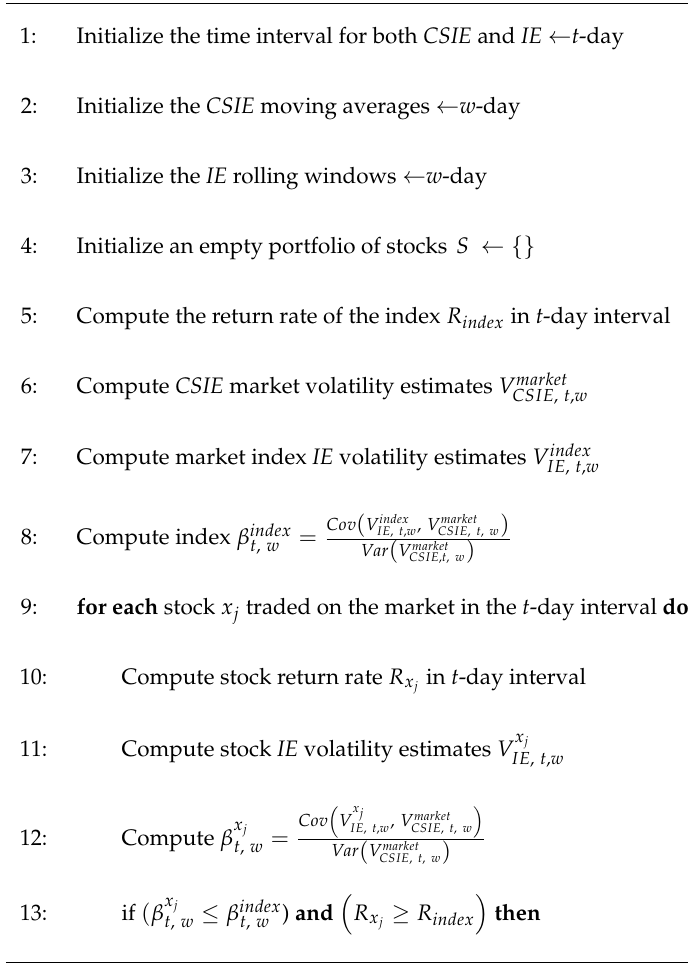
Algorithm 1 for computing the betas and selecting the symbols according to the dynamically imposed criteria is described as follows. Algorithm 1. Compute the conditional betas and select the symbols according to the dynamically imposed